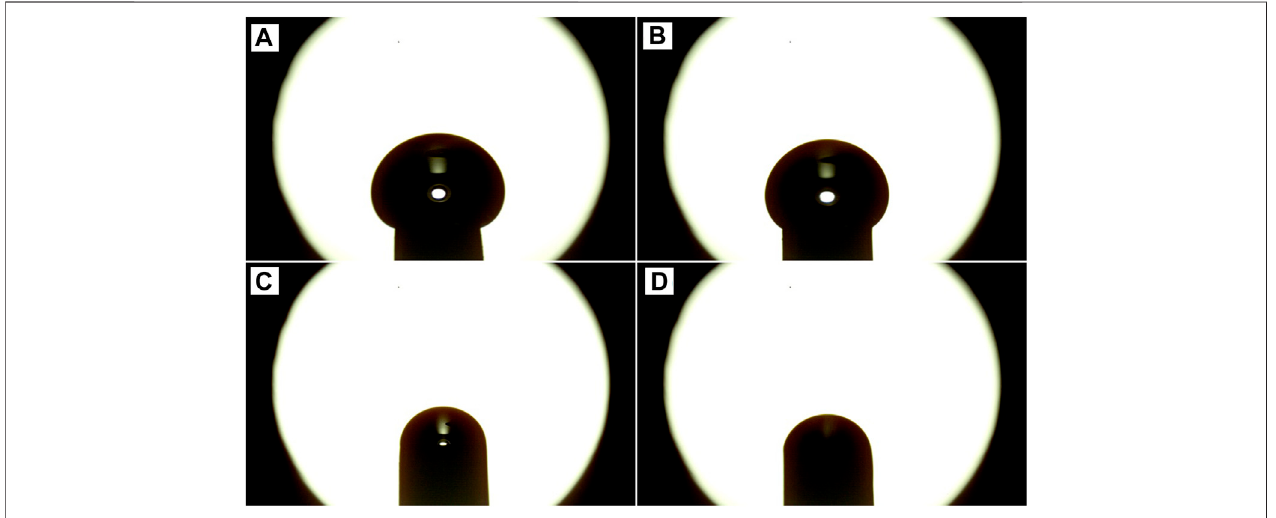
FIGURE 8 | Shape of different water droplets on stand, (A) 15% NaCl solution, (B) municipal water, (C) 0.005% surfactant solution, and (D) Hydraulic oil. HM46#.